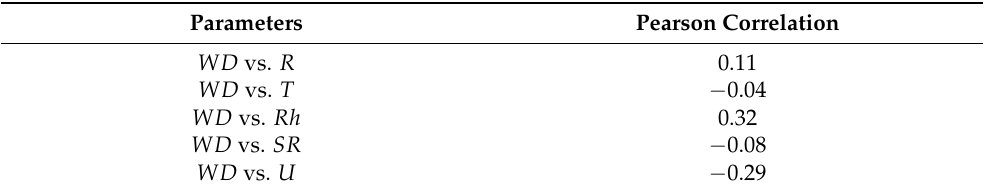
Table 2. Pearson’s correlation coefficients of the raw time series between wind direction ( WD )